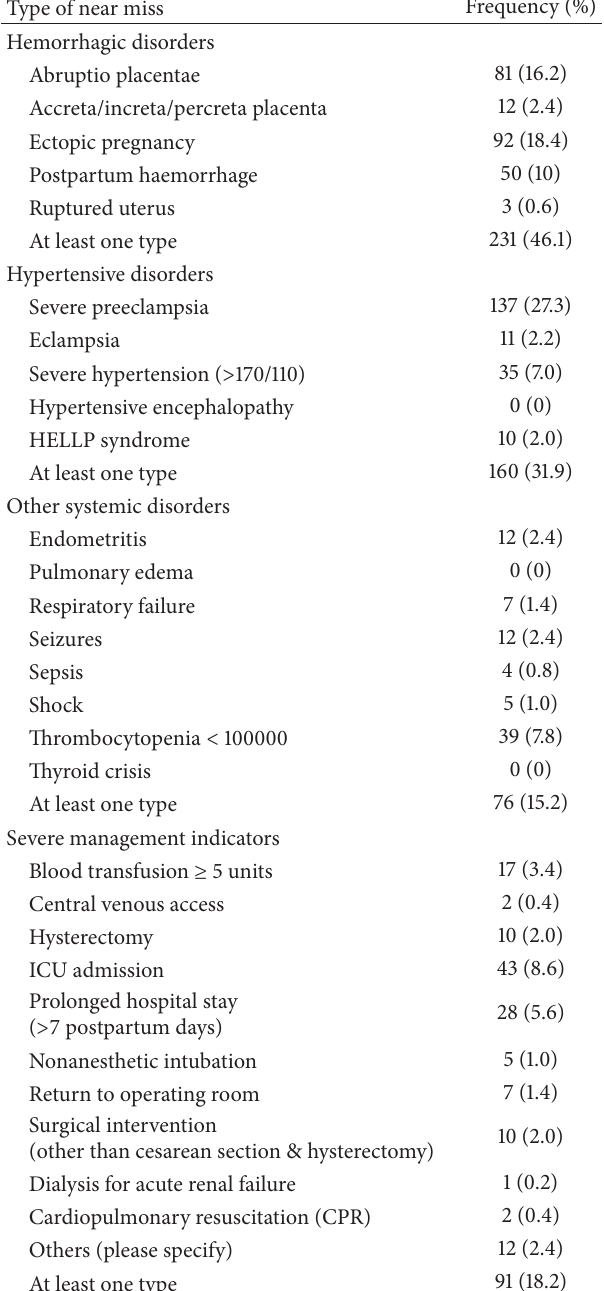
Table 3: Frequency of near miss criteria in 501 cases of severe maternal morbidity.